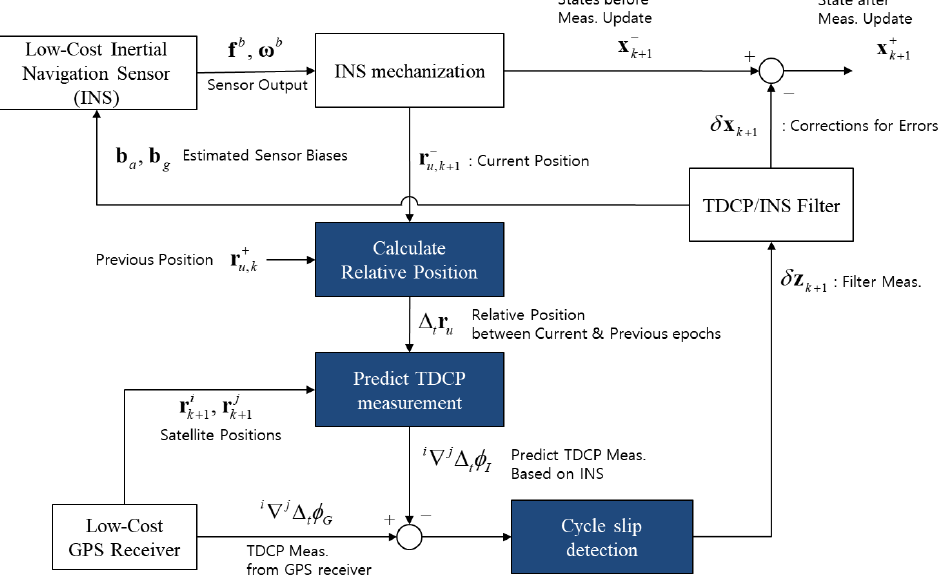
Figure 4. Configuration of the time-differenced carrier phase/inertial navigation sensor (TDCP/INS) navigation system.